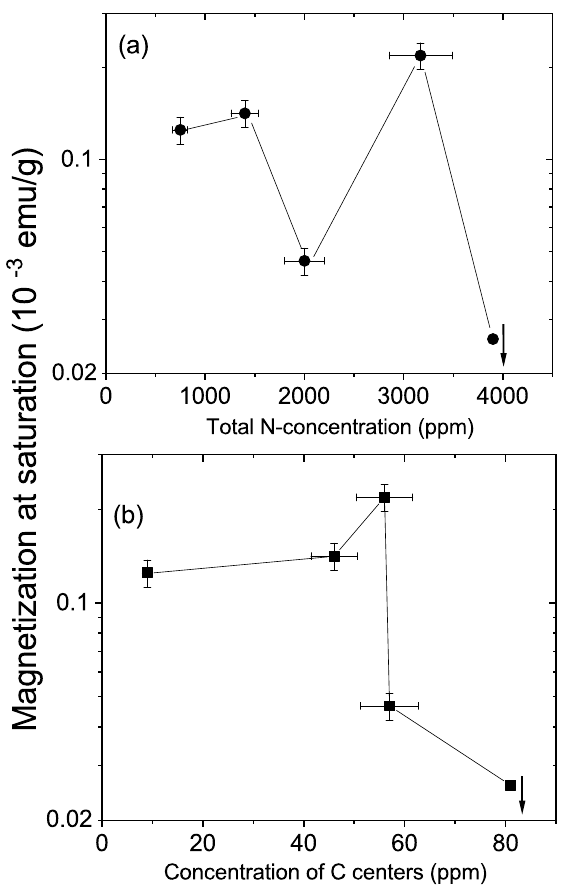
Figure 5. Magnetization at saturation at 300 K of the natural crystals vs. the total concentration of nitrogen ( a ) and of C centers ( b ). Because nitrogen was in all the sample volume, the magnetization was calculated taking into account the total mass of each sample. The down-arrow at the last point to the right means that the value of magnetization for that sample is below the limit of the